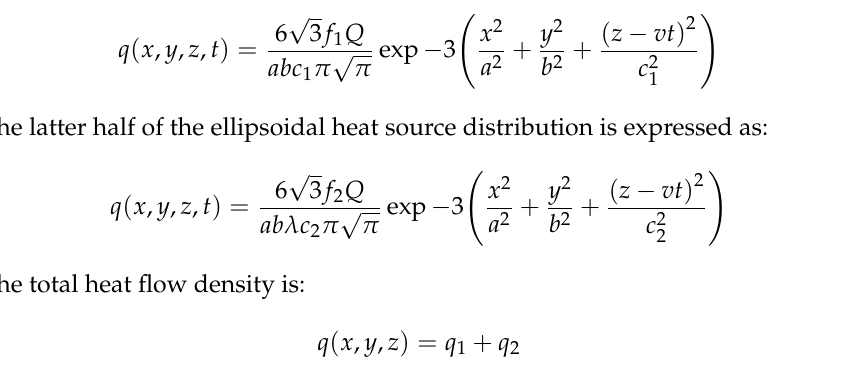
Figure 4. Modified model of the double-ellipsoid heat source. a is the half-width of the heat source, b is the depth of the heat source, C 1 is the length of the front quadrant of the heat source, and C 2 is the length of the rear quadrant of the heat source.